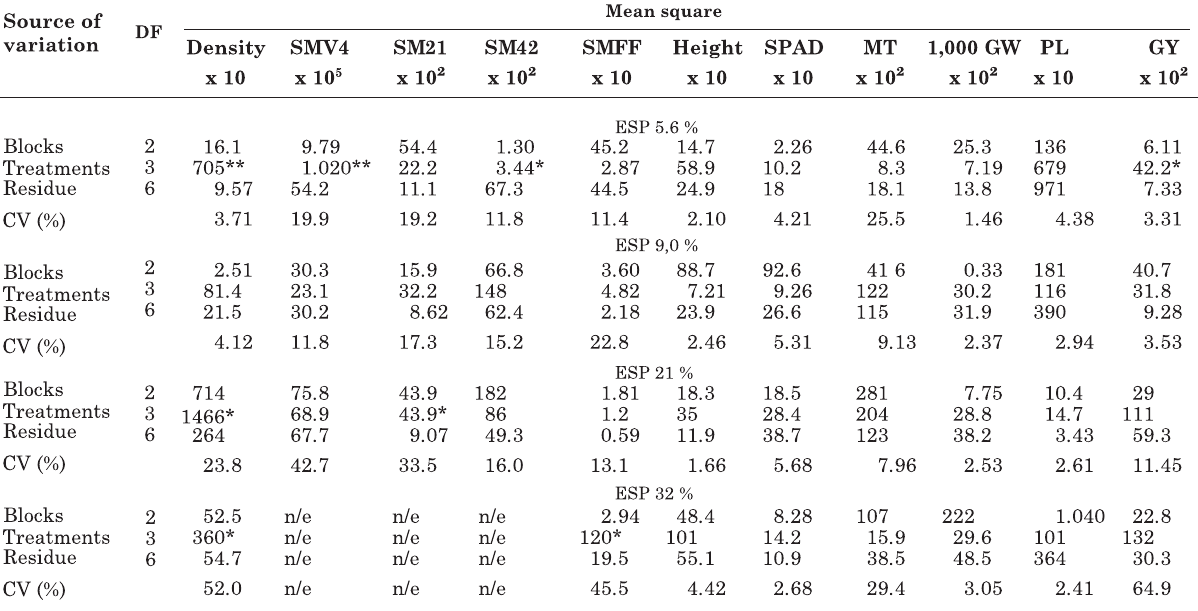
Table 2. Summary of analysis of variance for density, shoot mass in V4 (SMV4), shoot mass 21 days after flooding (SM21), shoot mass 42 days after flooding (SM42) shoot mass at full flowering (SMFF), plant height, chlorophyll meter reading (SPAD index), mass of tillers (MT), 1,000-grain weight (1.000